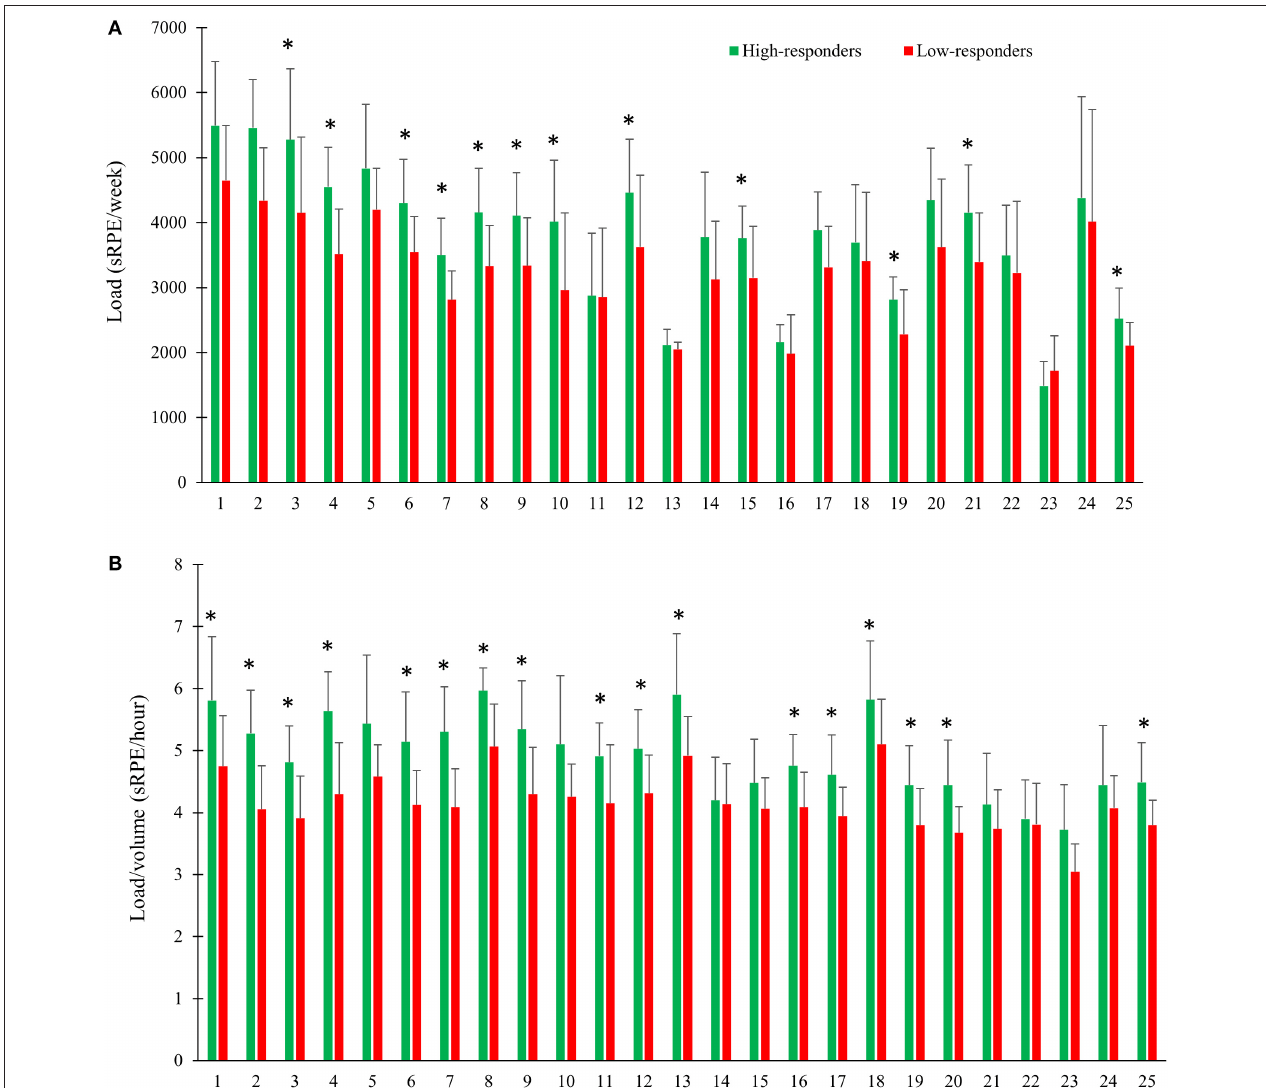
FIGURE 3 | Quantification of (A) weekly training load and (B) weekly load/volume ratio in high- vs. low-responders during a 6-month XC ski-specific training period. *Significant difference between groups ( P ≤